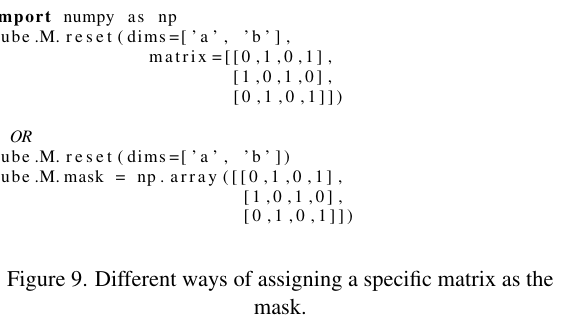
Figure 9. Different ways of assigning a specific matrix as the mask.